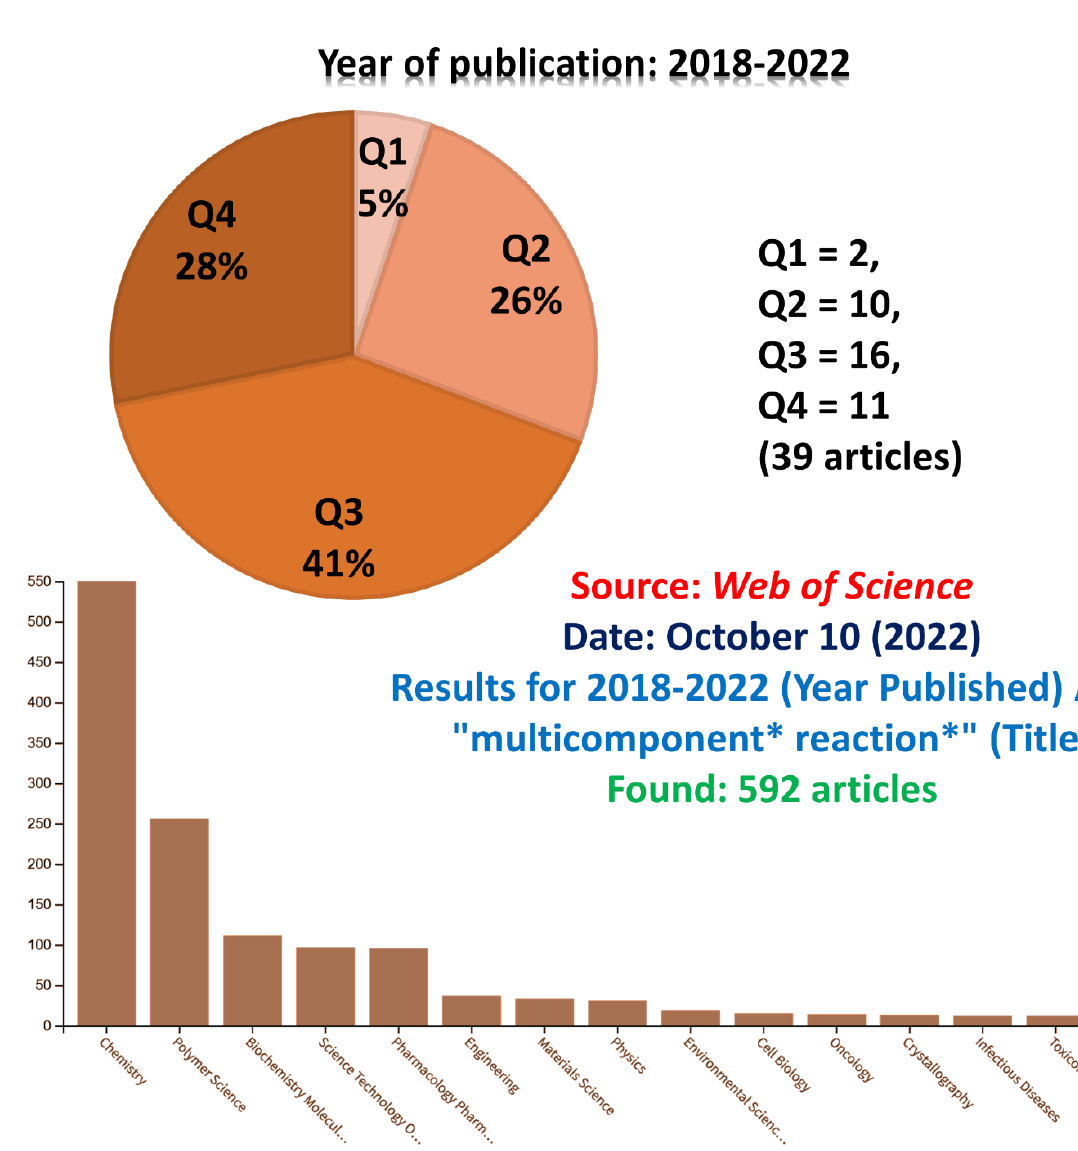
Figure 2. Results for 2018–2022 (year published) AND “multicomponent * reaction *” (Title). Found: 592 articles. Source: Web of Science .